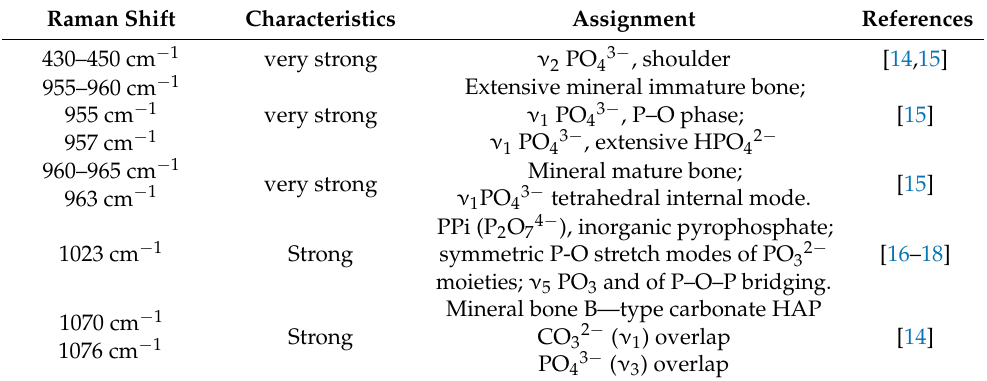
Table 2. Targeted Raman shift for bone specimens. Raman Shift Characteristics